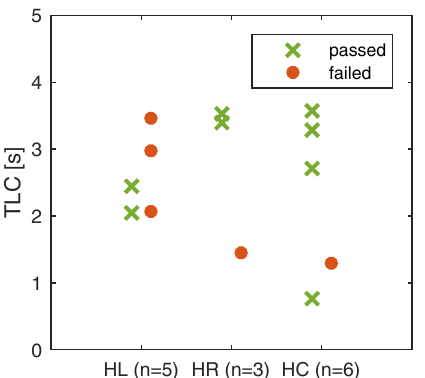
Figure 8 . Time to line crossing (TLC) for the patient groups and the control subjects. The means and standard deviations for subjects who passed and failed the driving task are de- picted as crosses (green) and circles (red), respectively. HC: control group, HR: HVFD patients with a right-sided visual field defect, HL: HVFD patients with a left-sided defect.